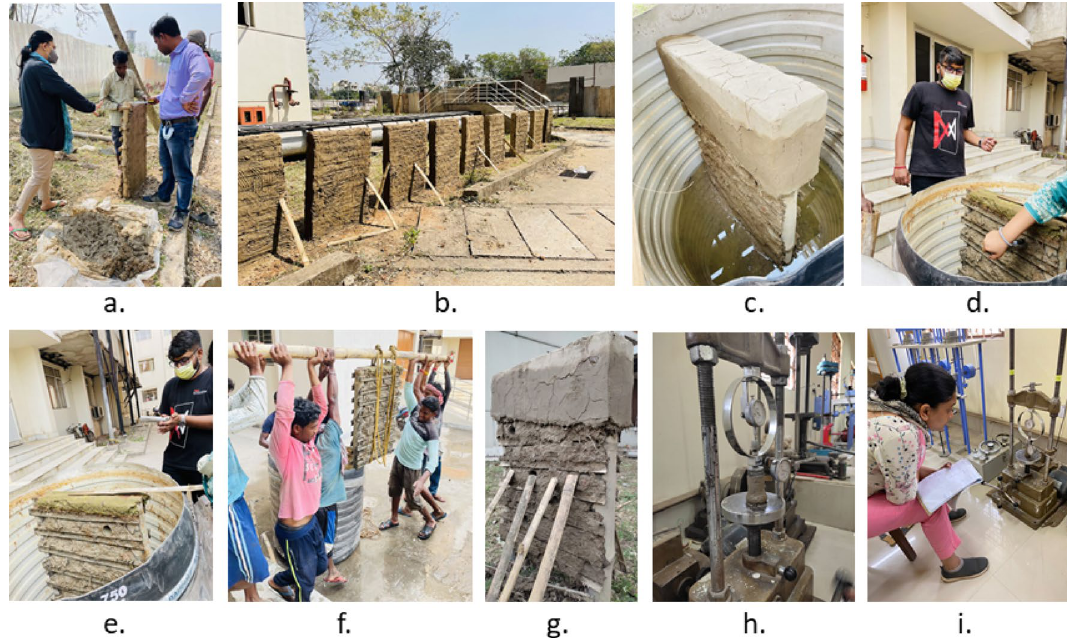
Figure 5. The experiment